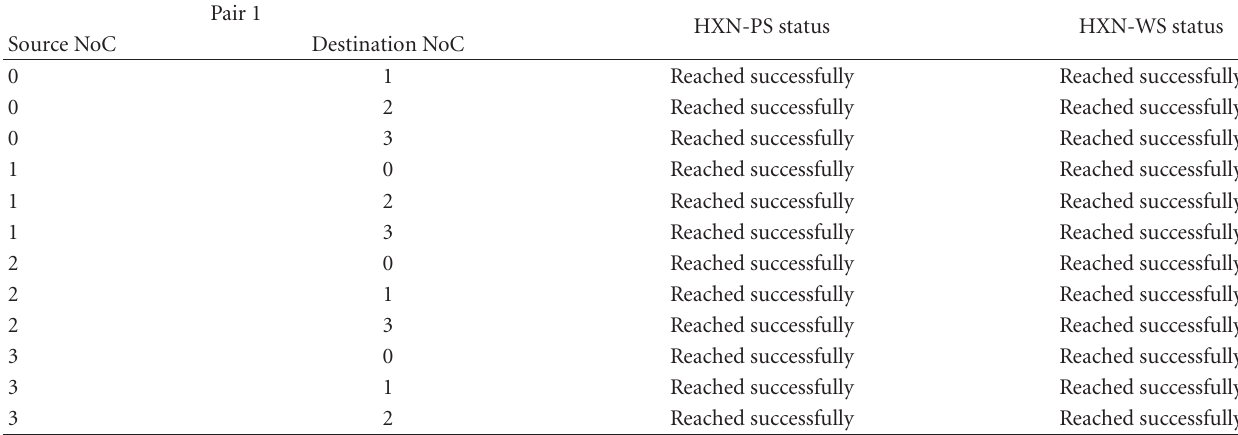
Table 24: The following source destination pair is used to show 100% e ffi ciency of the NiP (based on HXN, used as IoC). All source destination pair delivered the information to the respective NoC. The following data does not reflect the parallel communication among the NoCs using packet and wormhole switching algorithms.